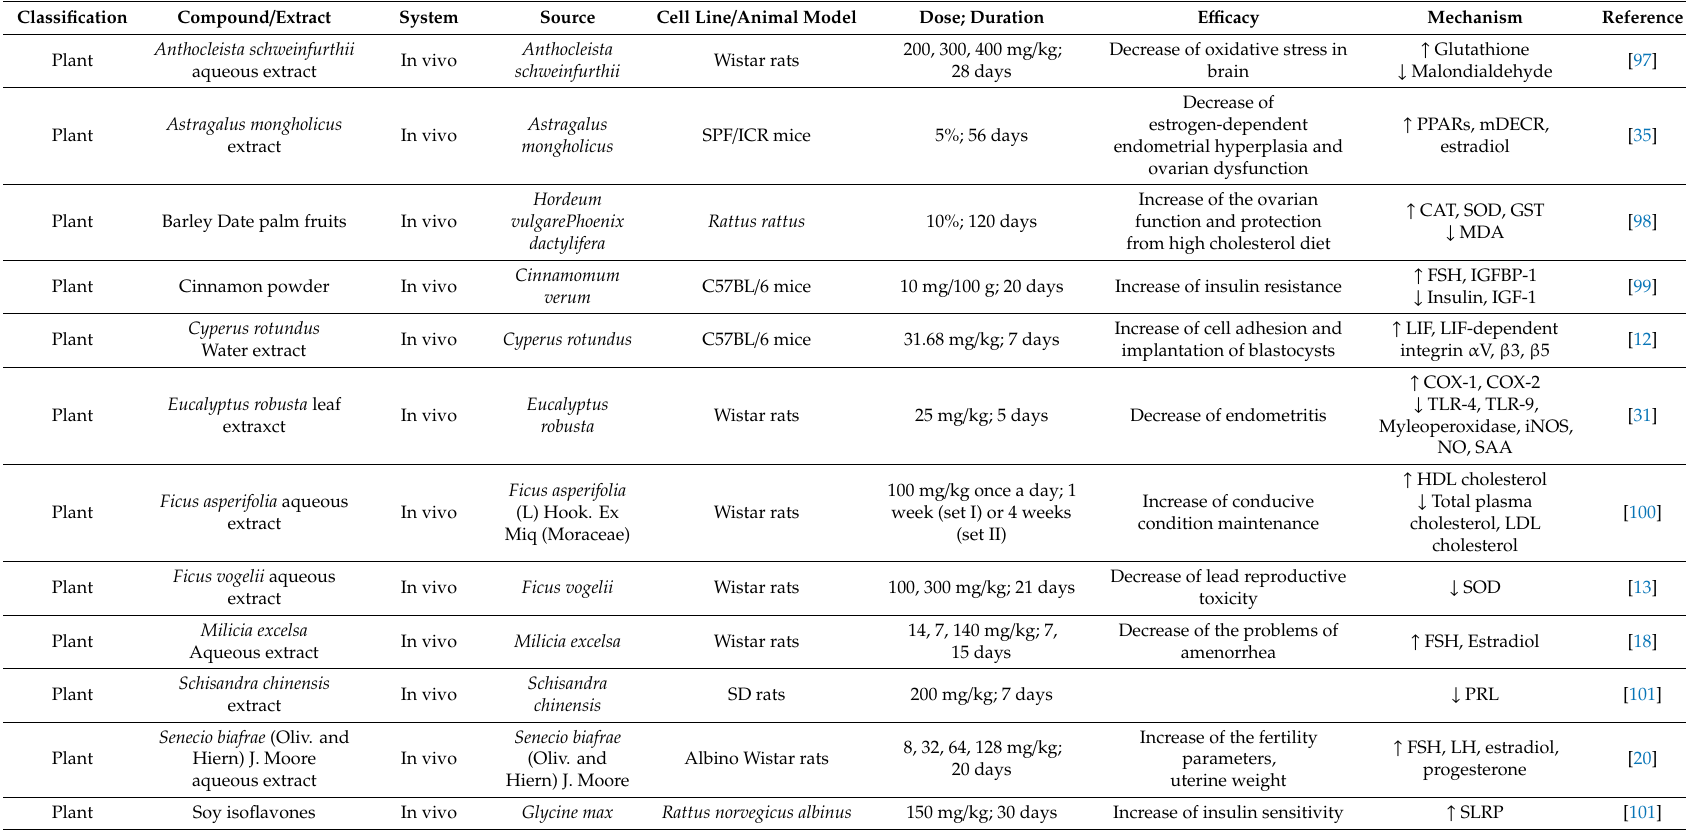
Table 8. Plant derived natural products and female infertility (in vivo